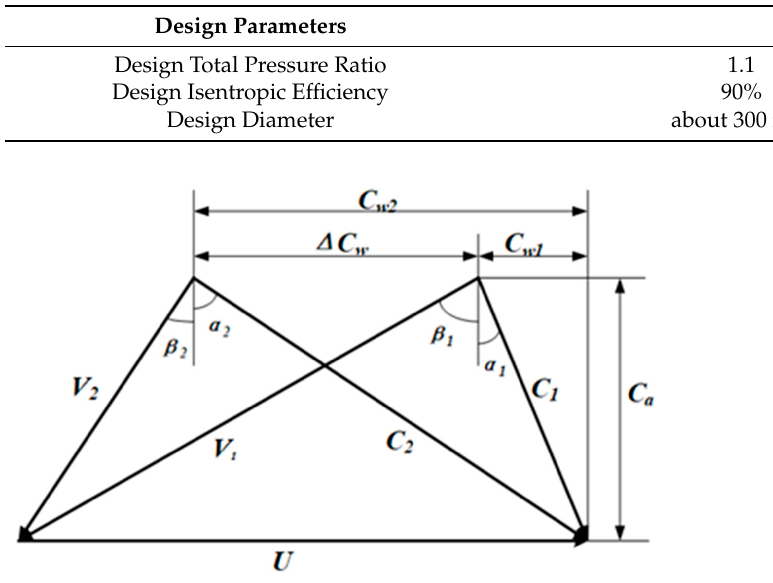
Table 1. Initial rotor design parameters.